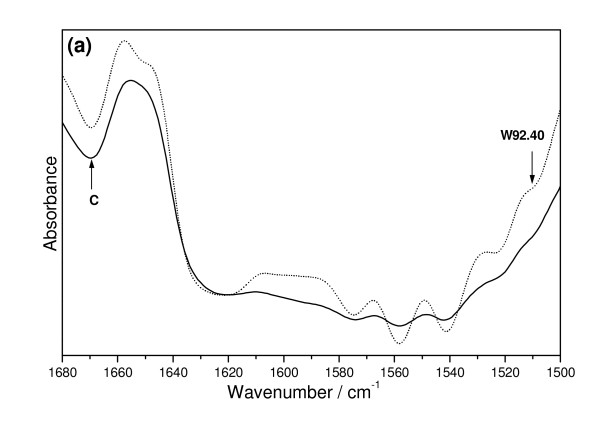
The IR contours from the region 1500 - 1680 cm-1 of oils from control(C) and transgenic (W92.40) flax plants. The 1657 cm-1 component is assigned to the ν(C = C) vibration in synapic acid, ferulic acids and kaempferol. The band at 1608 cm-1 fits to standard spectra for secoisolariciresinol (SECO), secoisolariciresinol diglucoside (SDG) and coumaric acid. The 1589 cm-1 band is characteristic for ferulic, coumaric and synapic acids. Bands at 1567 cm-1 correspond to kaempferol, at 1512 -1515 cm-1 to the SECO, SDG and coumaric acid and 1517 cm-1 to synapic acid and SECO.